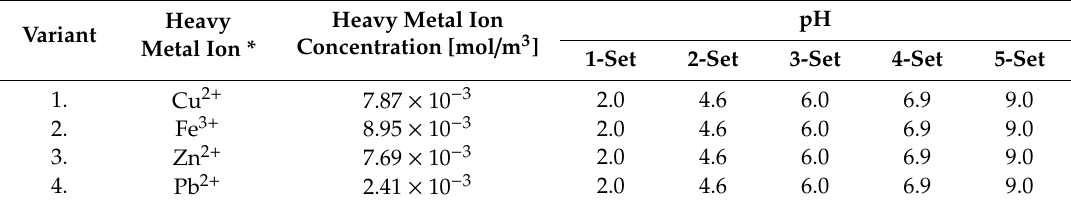
Table 4. Variants of parameters